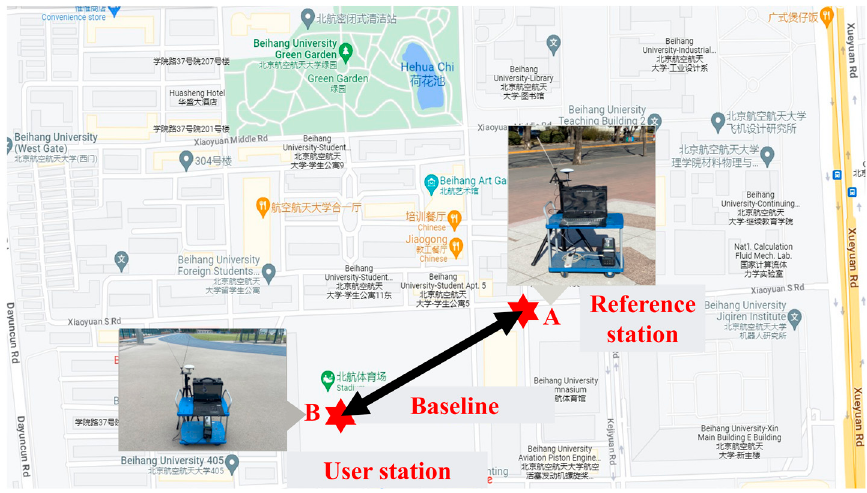
Figure 6. Experiment site.